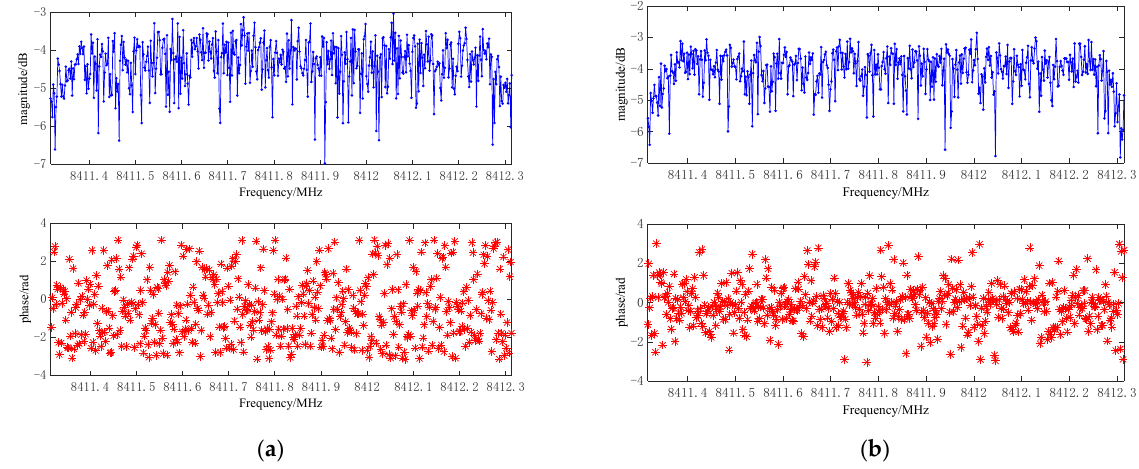
Figure 9. Comparison of fringes: ( a ) original fringe of cross spectrum of integration time, without proper clock information contained in apriority delay model, and no fringe could be identified; ( b ) fringe of cross spectrum of integration time, with proper clock information estimated.